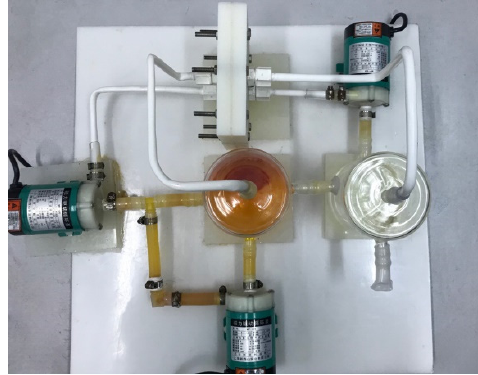
Figure 4. A photo of our novel ZnBr 2 single cell system.